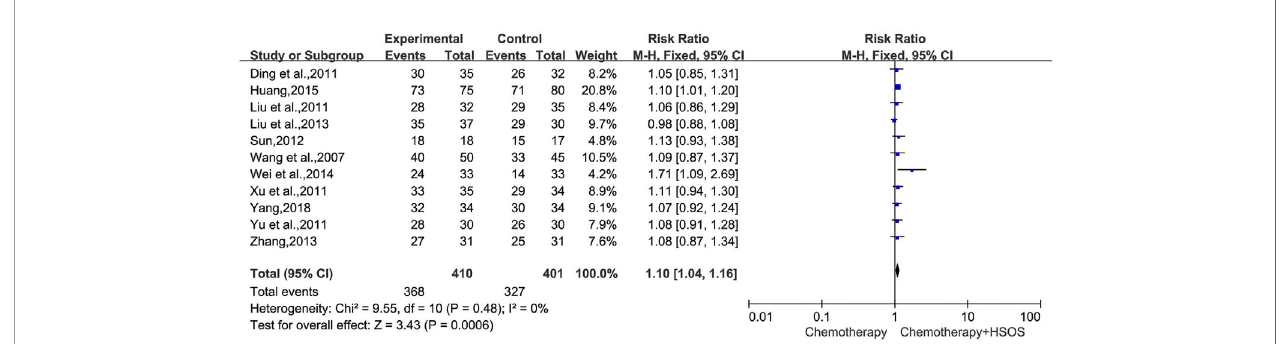
FIGURE 4 | Forest plot of improved DCR with chemotherapy combined with HSOS versus chemotherapy alone.